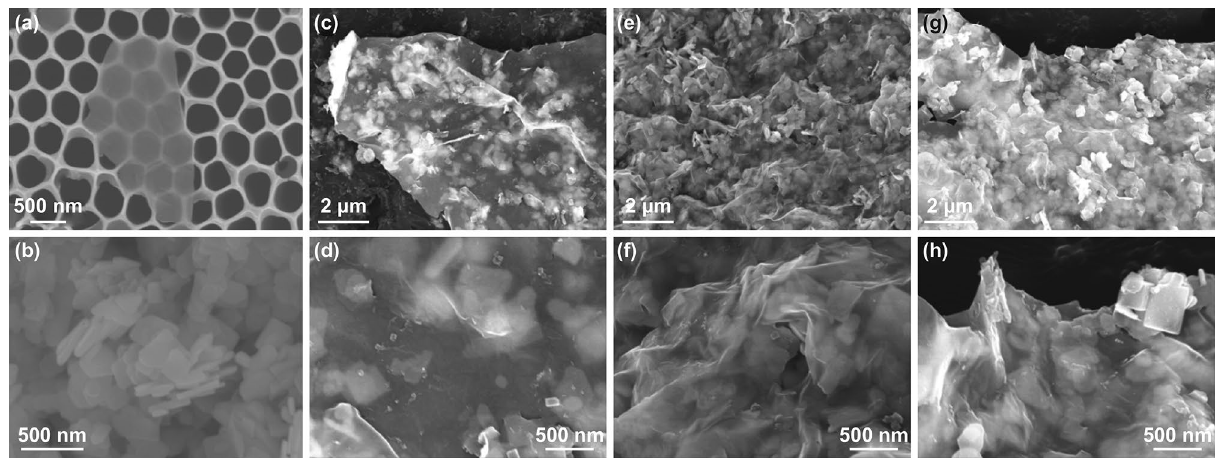
Fig. 2 SEM images of a MXene nanosheets, b Bi 2 MoO 6 nanoplates, c , d Bi 2 MoO 6 /MXene‑50%, e , f Bi 2 MoO 6 /MXene‑30%, and g , h Bi 2 MoO 6 /